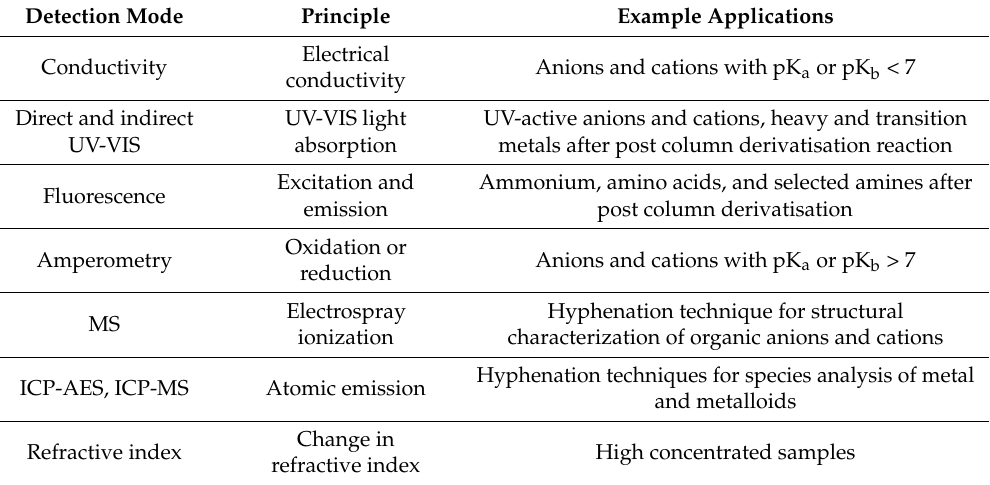
Table 2. Detection methods applied in ion